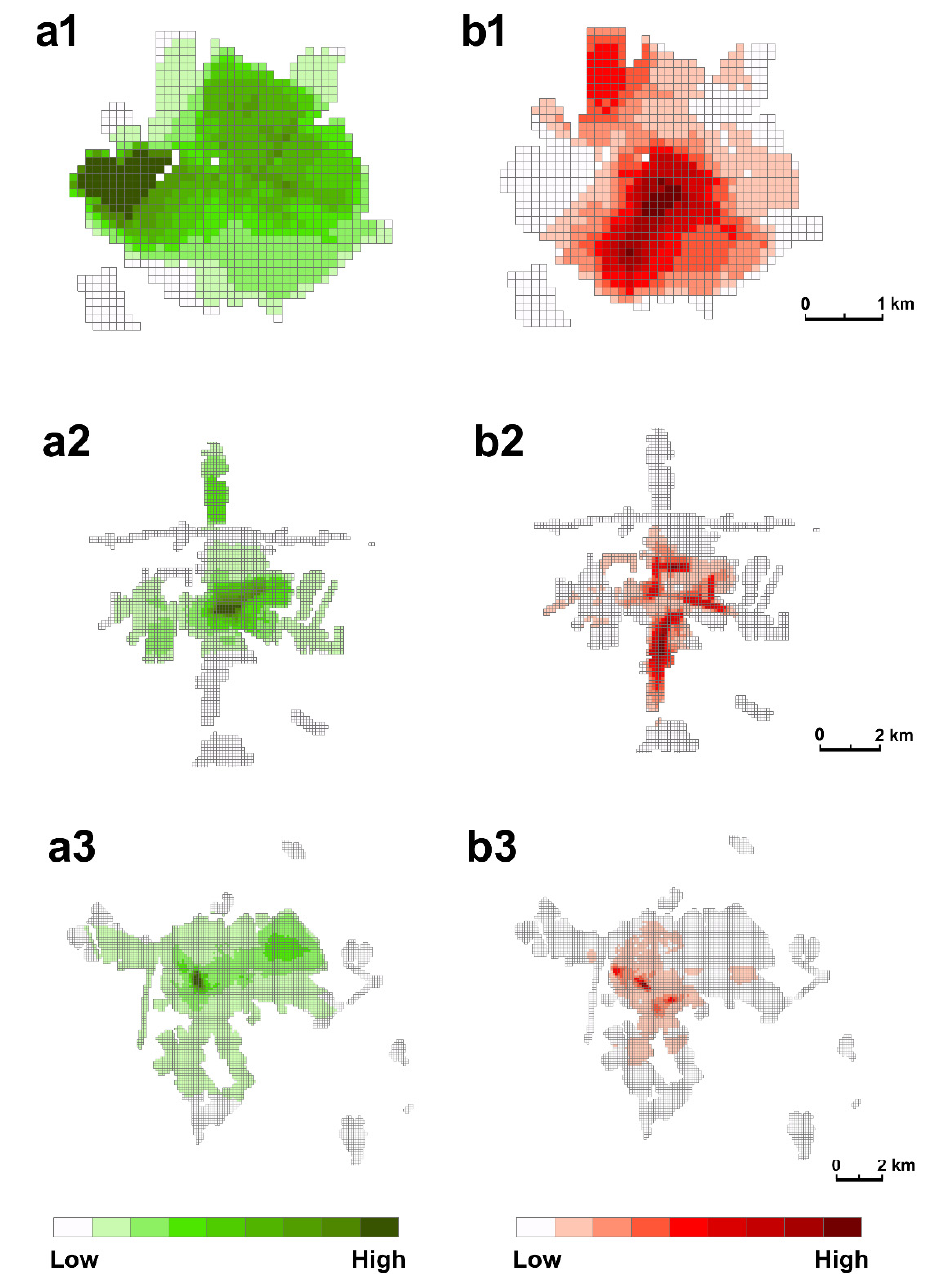
Figure 2. Local (normalized) number of times a place was marked as ( a ) safe or ( b ) unsafe (in some selected cities): ( 1 ) Balmaz ú jv á ros; ( 2 ) Nagykanizsa; ( 3 ) Sz é kesfeh é rv á selected cities): ( 1 ) Balmazújváros; ( 2 ) Nagykanizsa; ( 3 ) Székesfehérvár.